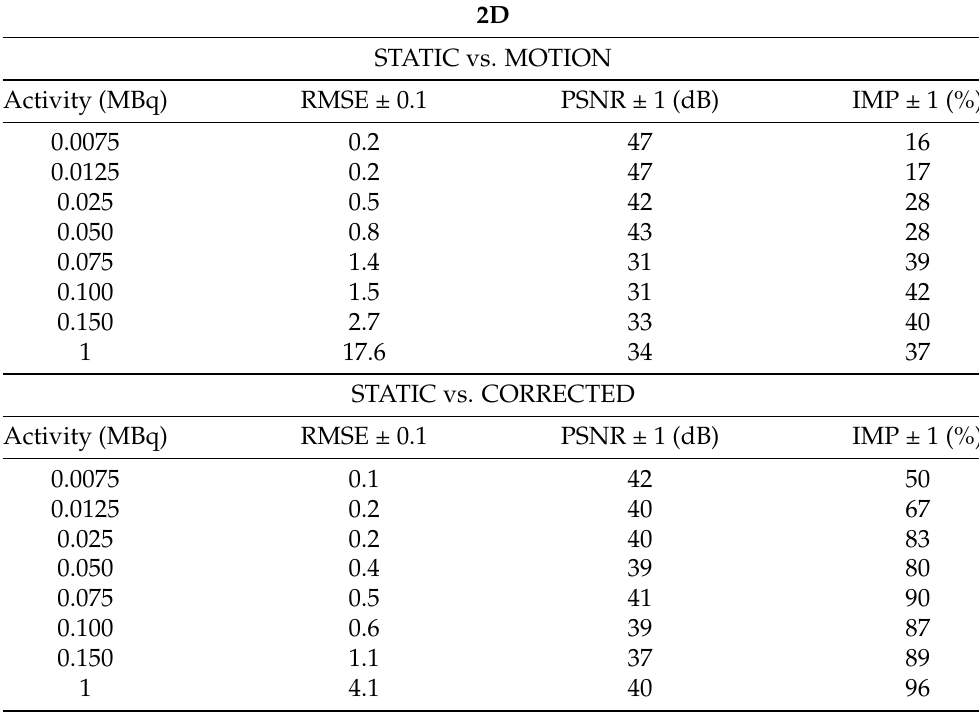
Table 5. RMSE, IMP, and PSNR values for “infinite”-type motion (Bernoulli’s lemniscate) in two dimensions for different source